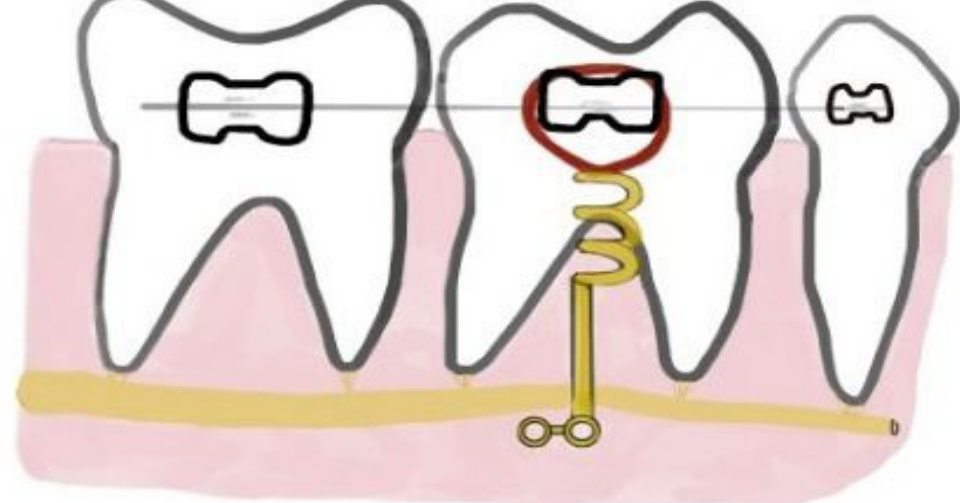
Figure 4. Attention to the insertion of orthodontic miniscrew (OMs) in the presence of the inferior alveolar nerve.